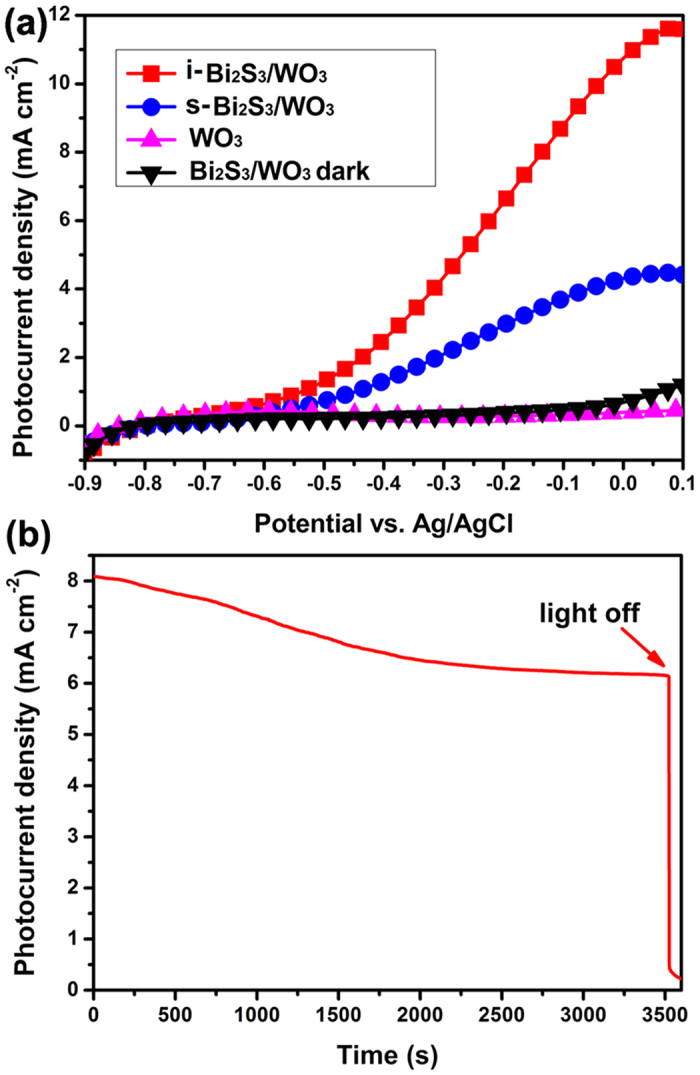
(a) LSV scans of s-Bi2S3/WO3 and i-Bi2S3/WO3 films and (b) the photocurrent−time plot of i-Bi2S3/WO3 photoelectrodes.